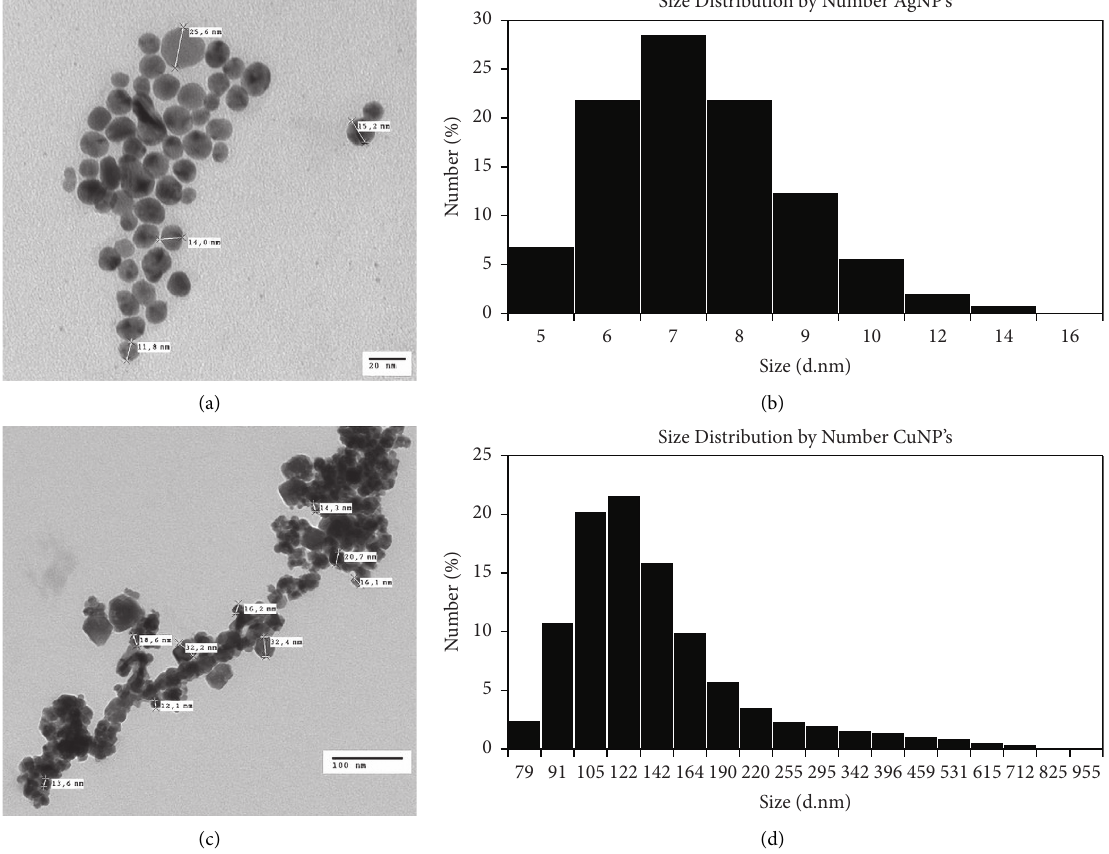
Figure 4: Dynamic light scattering measurements and TEM images. (a) TEM silver nanoparticles, (b) DLS silver nanoparticles, (c) TEM copper nanoparticles, and (d) DLS copper nanoparticles.